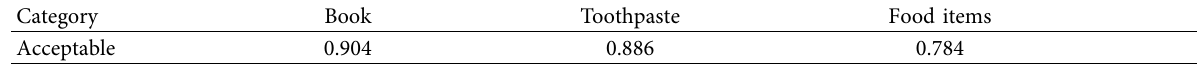
Table 4: The product acceptance index for the online